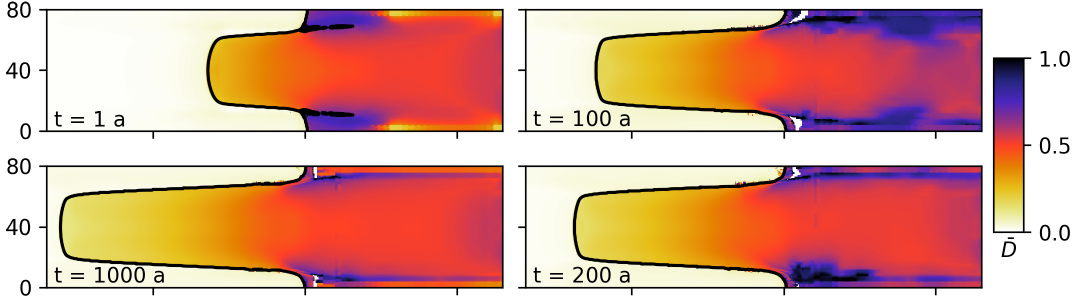
Figure 2. Evolution of the damage field D and the grounding line in IceD, starting from a steady state with D = 0. The immediate result of “switching on” the damage model is the creation of a heavily damaged ice shelf (with D ∼ 0 . 5). Over time, this weaker ice shelf results in the grounding line (solid black contour) retreating over more than 100km. At the same time spots of intense damage ( D ∼ 0 . 9) generated where the grounding line crosses the channel walls around x = 500km and y = { 10 , 70 } km are transported downstream, to form strips that extend to the calving front.